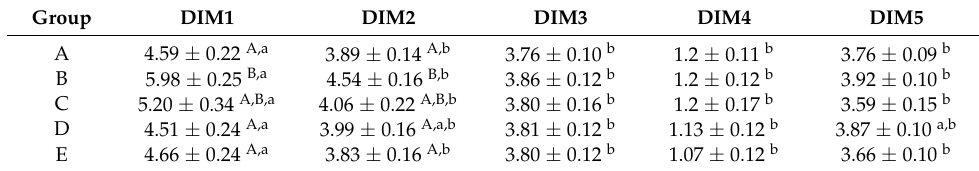
Table 3. Averaged milk fat (%) pattern by group over the first five months of lactation. Group